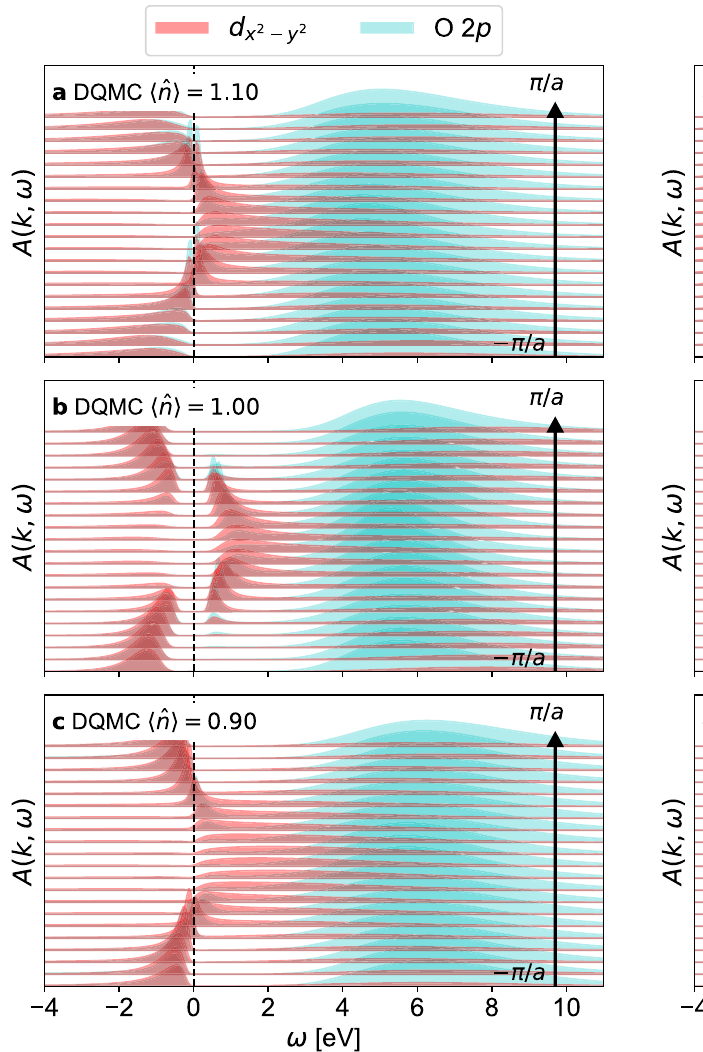
Fig. 3 The single particle spectral function A ( k , ω ) of the multi-orbital model computed using the density matrix renormalization group (DMRG) method. Results are shown as a function of momentum k and energy ω for fi llings of a h ^ n i ¼ 1 : 1, b h ^ n i ¼ 1, and c h ^ n i ¼ 0 : 9 holes/Cu. Red color represents Cu d x 2 (cid:1) y 2 , while cyan color represents the sum of O p x and O p ± y components. From bottom to top, the momentum k increases from − π / a to π / a in each panel. All results were obtained on chains with N = 20 unit cells and onsite energies ϵ d = 0, ϵ p , x = 3, and ϵ p , y = 3.5, hopping integrals ∣ t ( p , x ) d ∣ = 1.5, ∣ t ( p , y ) d ∣ = 1.8, and ∣ t pp ∣ = 0.75, and Hubbard interactions U d = 8, U p = 4, and U pd = 1, in units of